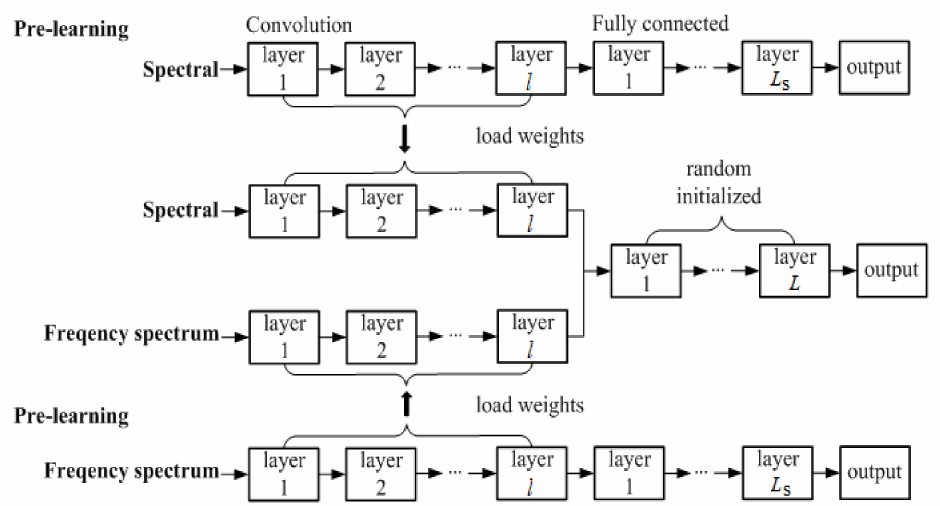
Figure 4. Schematic diagram of the proposed pre-learning strategy.